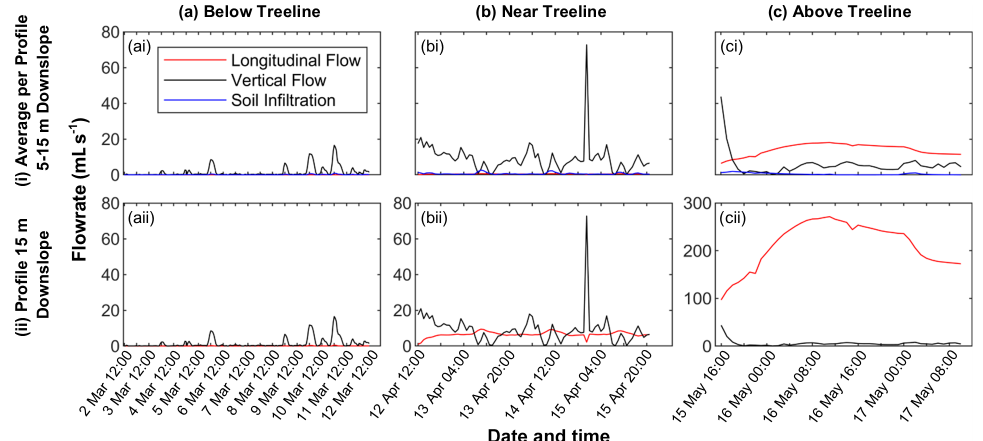
Figure 5. Results of SnowTOUGH simulations over the entire intensive observations periods (IOPs) for the study sites (a) below the treeline (BT), (b) near the treeline (NT), and (c) above the treeline (AT). Results shown are (i) the average longitudinal flow, vertical flow, and infil- tration across the snow–soil interface per square meter area of hillslope from 5 to 15m downslope in simulated plots and (ii) the longitudinal flow and vertical flow rates at 15m downslope for a 1m 2 area of hillslope.